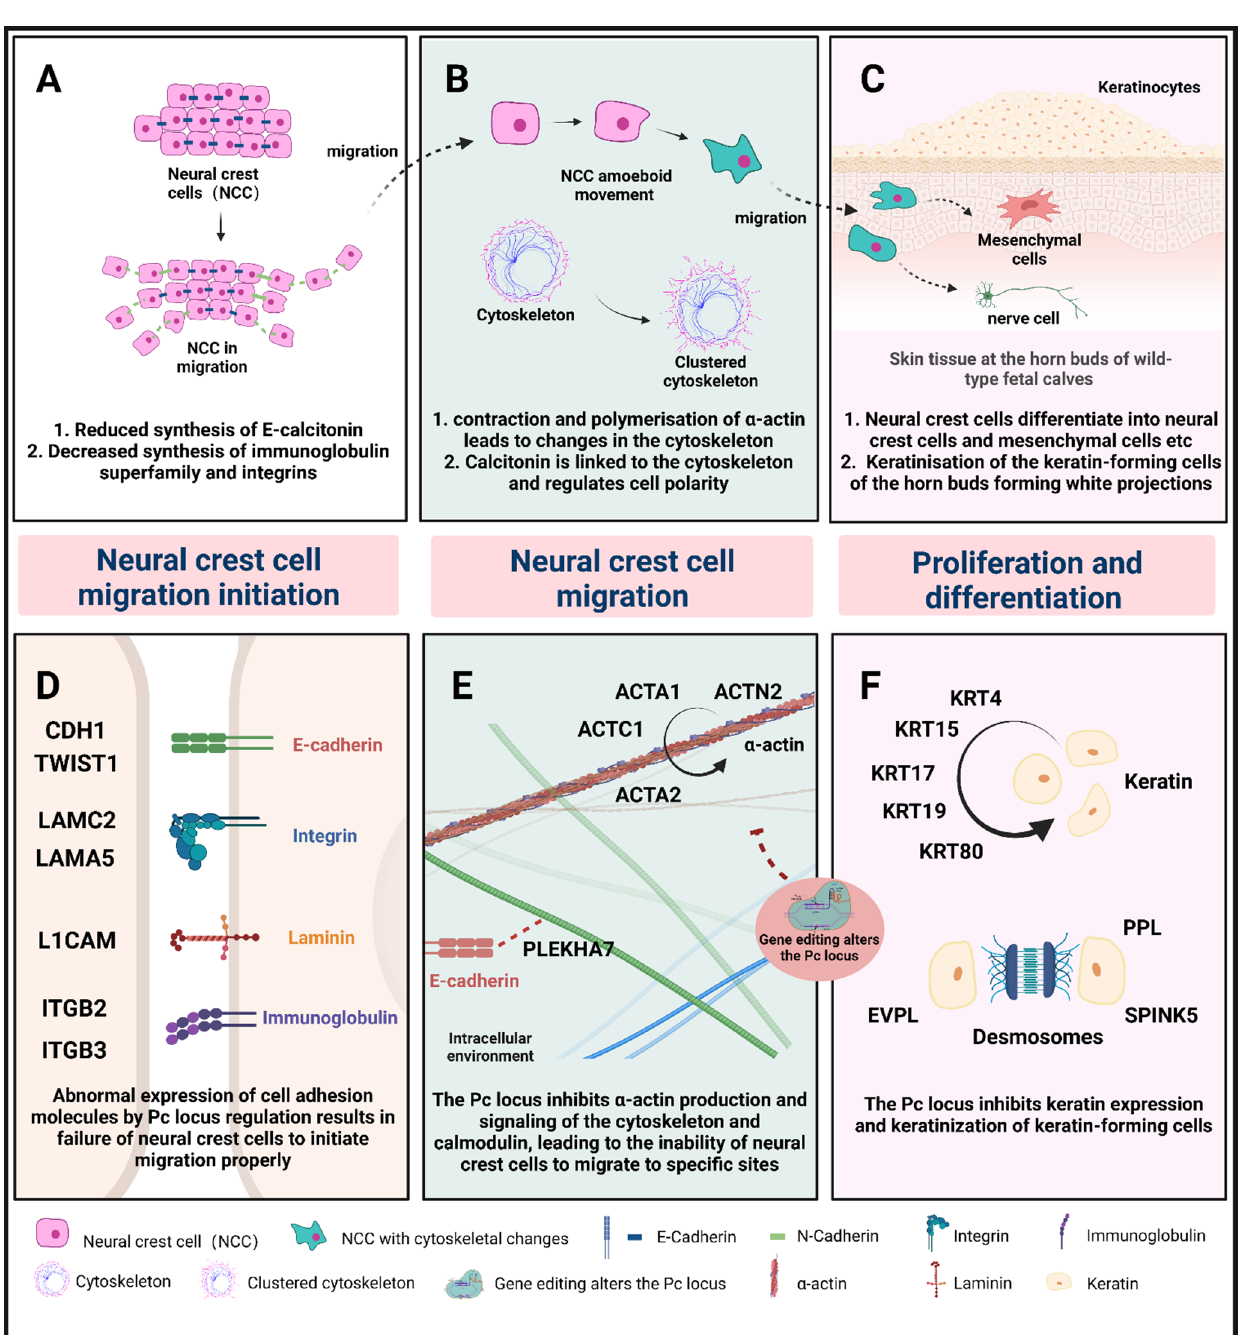
Figure 9. The possible mechanism by which the Pc locus regulate the polled phenotype. ( A ) Reduced expression of cell adhesion molecules such as E-calcitonin. Cells start to disperse. ( B ) The neural crest cytoskeleton changes and migrates to specific sites. ( C ) Neural crest cells differentiate into nerve cells and interstitial cells, etc., which are involved in horn formation. ( D ) Abnormal expression of cell adhesion molecules by Pc locus regulation results in the failure of neural crest cells to initiate migration properly. ( E ) The Pc locus inhibits a-actin production and signaling of the cytoskeleton and calmodulin, leading to the inability of neural crest cells to migrate to specific sites. ( F ) The Pc locus inhibits keratin expression and keratinization of keratin-forming